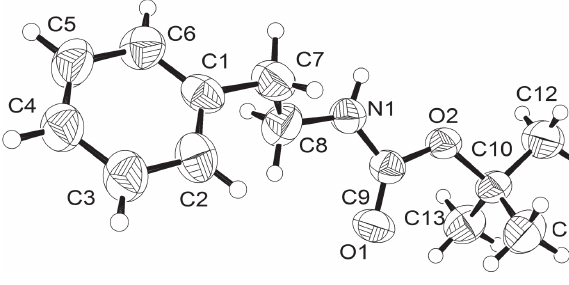
Table 1: Data collection and handling.